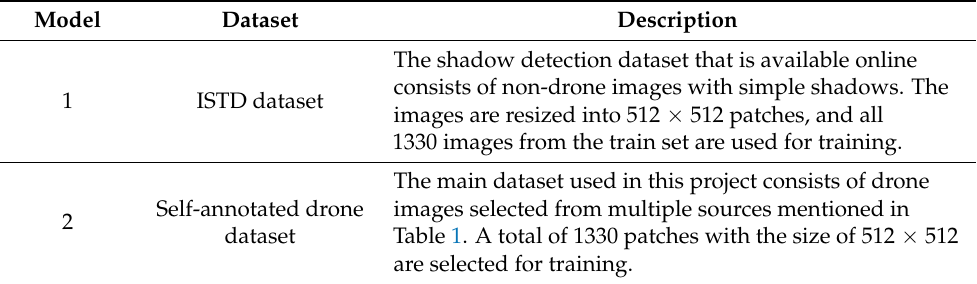
The main dataset used in this project consists of drone images selected from multiple sources mentioned in Table 1. A total of 1330 patches with the size of 512 × 512 dataset are selected for